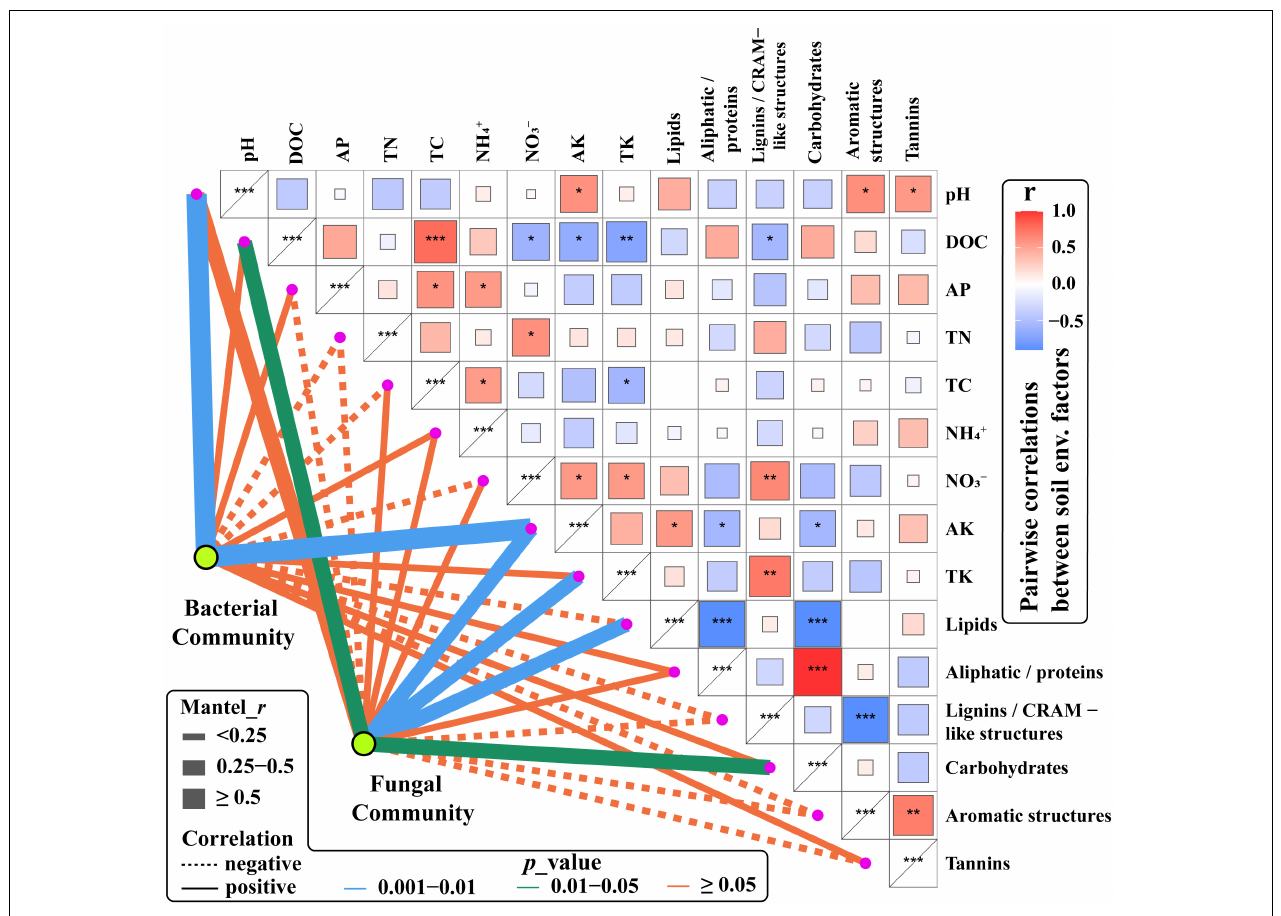
FIGURE 6 | Partial Mantel tests of pairwise comparisons of soil chemical properties and DOM composition with bacterial and fungal communities. Line width is proportional to the Mantel r values, line color denotes the significance level, and lien formatting indicates the correlation sign (solid line is a positive correlation and dashed lines are a negative correlation). ***: Significantly correlated at 0.001 level; **: Significantly correlated at 0.01 level; *: Significantly correlated at 0.05